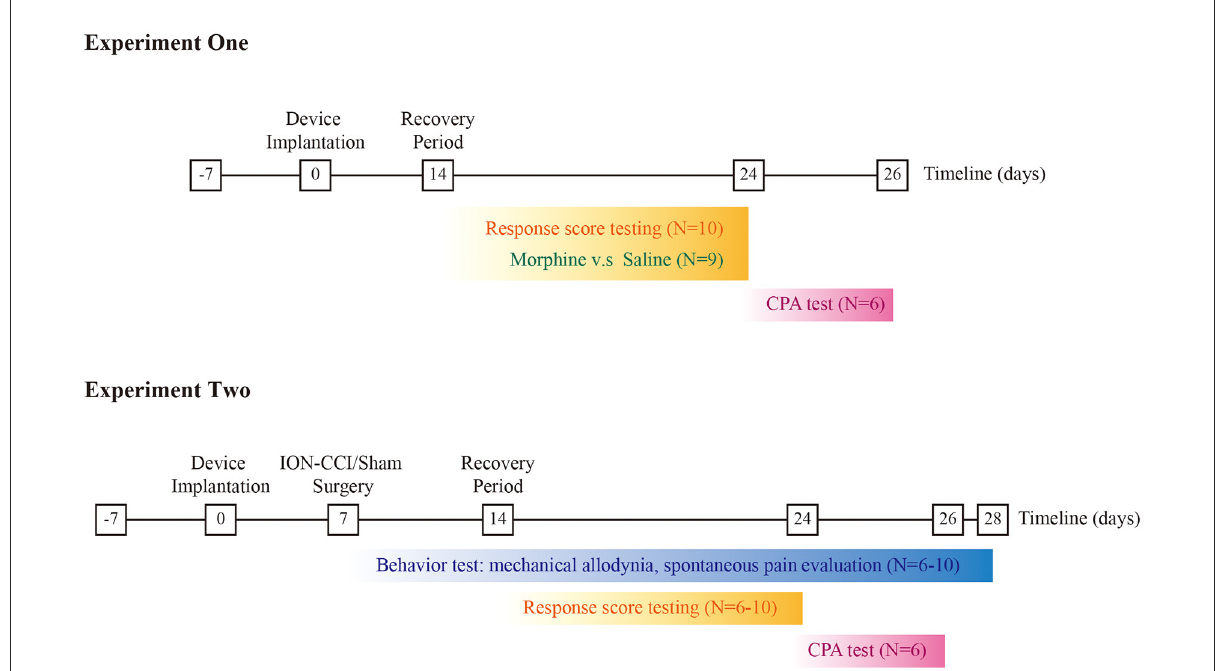
FIGURE1 Schematic of experimental design. Top panel refers to the experiment one, and the bottom panel for the experiment two